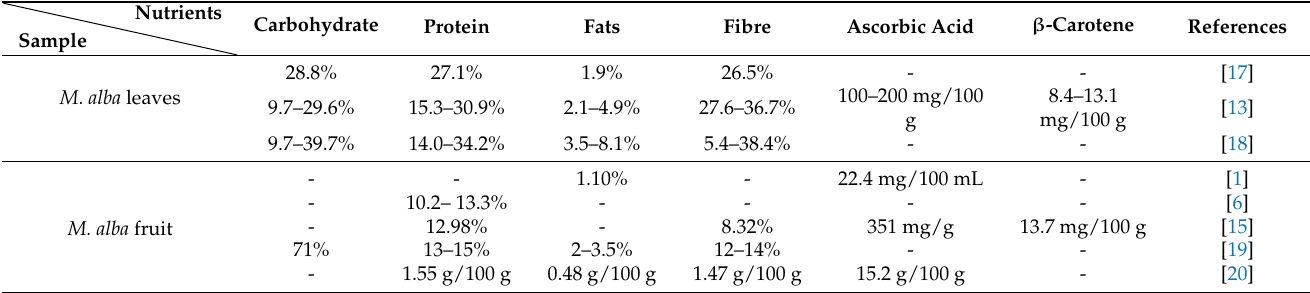
Table 1. Macronutrients and vitamins in M. alba .